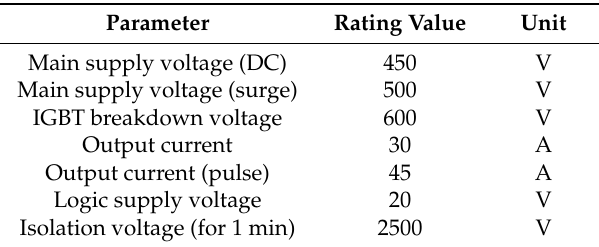
Table 3. Specifications of the inverter SCM1246MF.